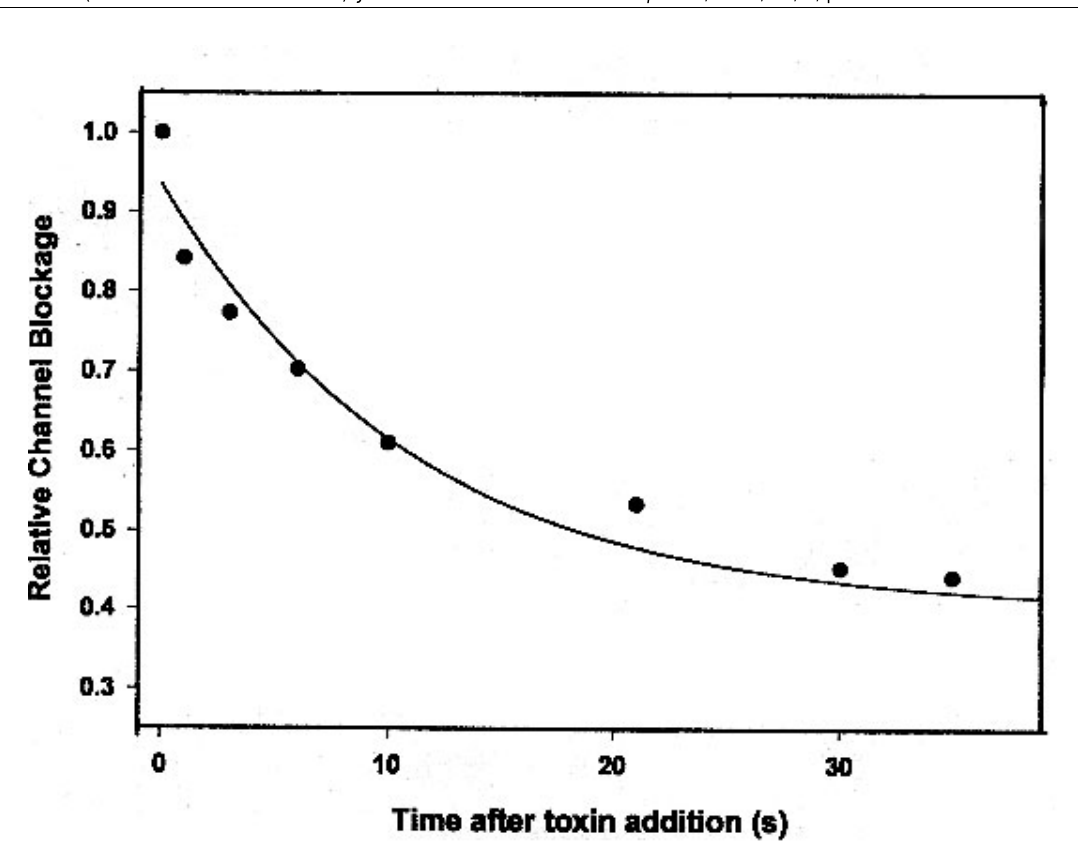
Figure 6f: Effect of the toxin at a given concentration at a single potential at different times. Time-dependence of the toxin